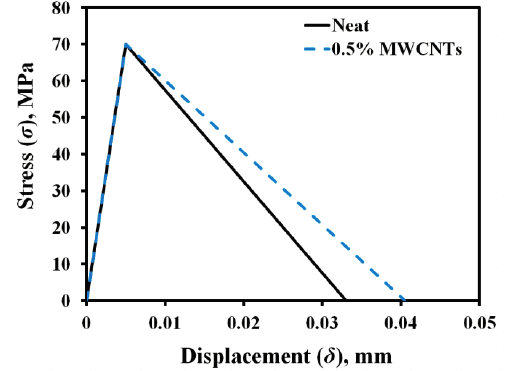
Figure 20. The normal stress-crack opening displacement relationships for unidirectional CFRP composites containing neat and 0.5 wt%